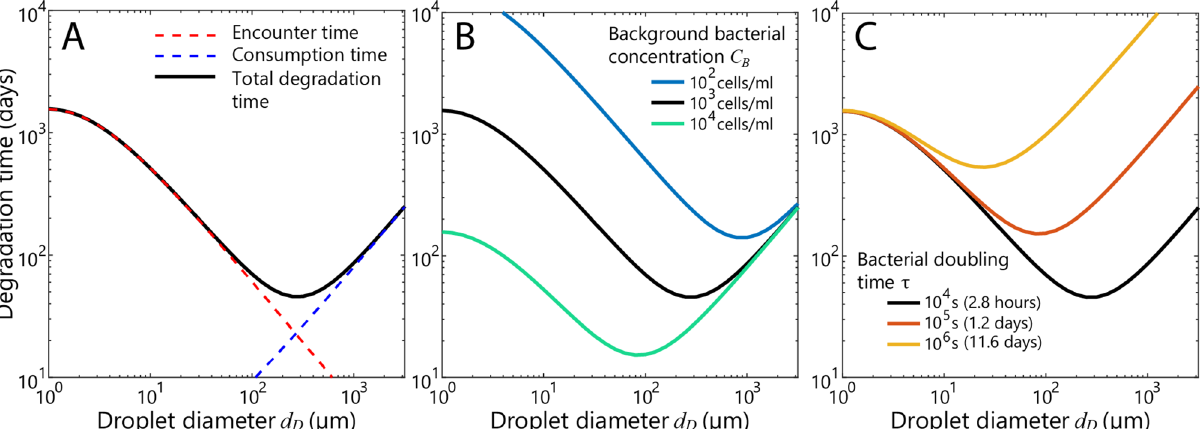
Figure 2. Biodegradation time of an average single oil droplet. (a) The average biodegradation time for a single droplet described by Eq. (1), using the environmental and biological parameters from Supplementary Table 1. The contributions from the encounter time (red dashed line) and the consumption time (blue dashed line) illustrate the tradeoff of the two processes in terms of droplet diameter. (b) Environmental parameters, here the background bacterial concentration C B , can have a major effect on the encounter-driven contribution to the biodegradation time (the portion of the curves left of the minimum). (c) Biological parameters, here the bacterial doubling time, can have a major effect on the consumption-driven contribution to the biodegradation time (the portion of the curves right of the minimum). The environmental and biological parameters of the system alter the droplet size for which the biodegradation time is